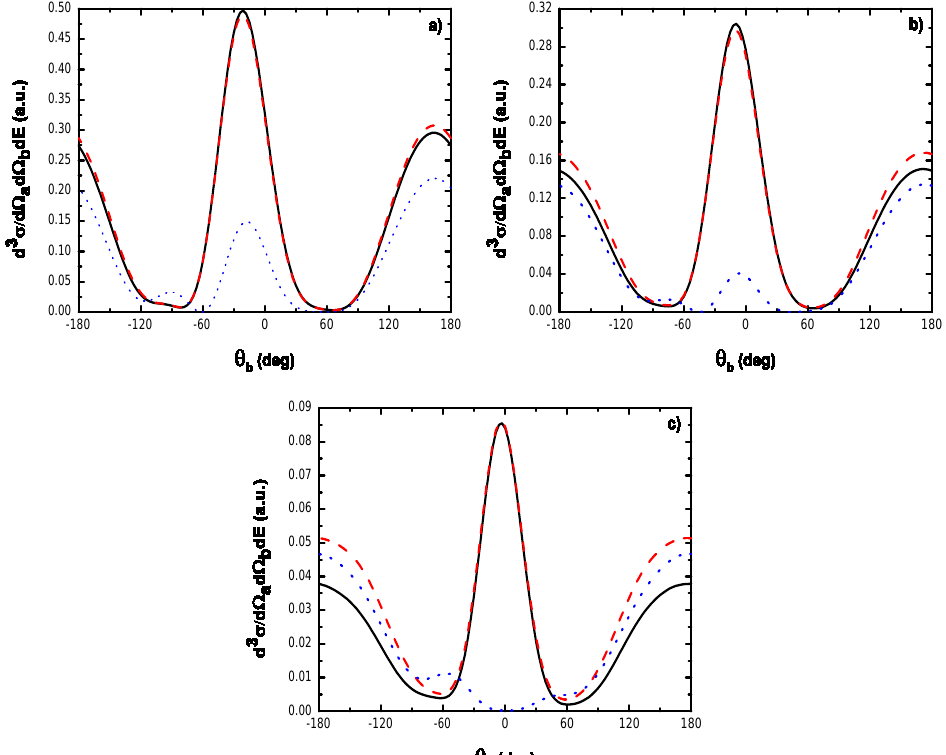
Figure 6. The same as in Figure 4, but with the emission of one photon ( (cid:96) = − 1 )